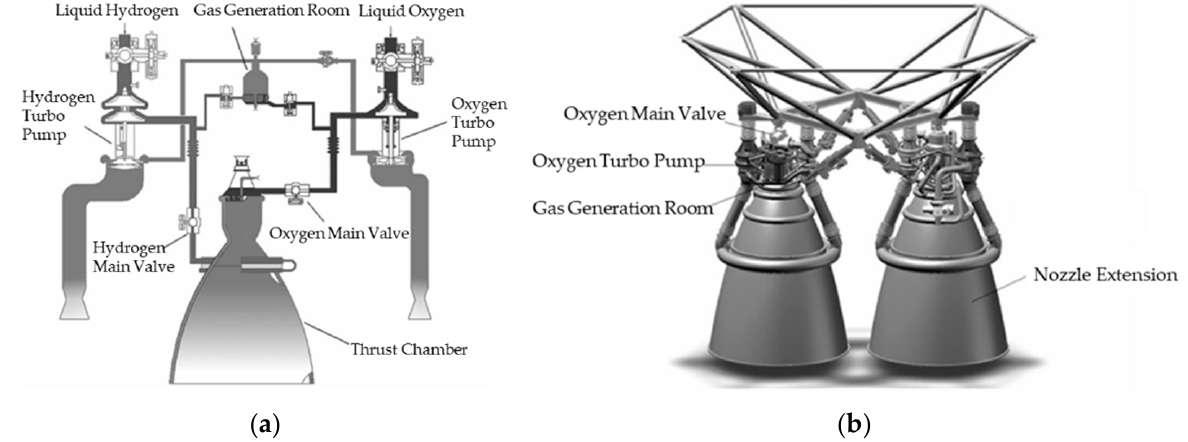
Figure 1. ( a ) The principle of 200-ton LH2/LOX rocket engine; ( b ) the structure of a 200-ton LH2/LOX rocket engine [15].